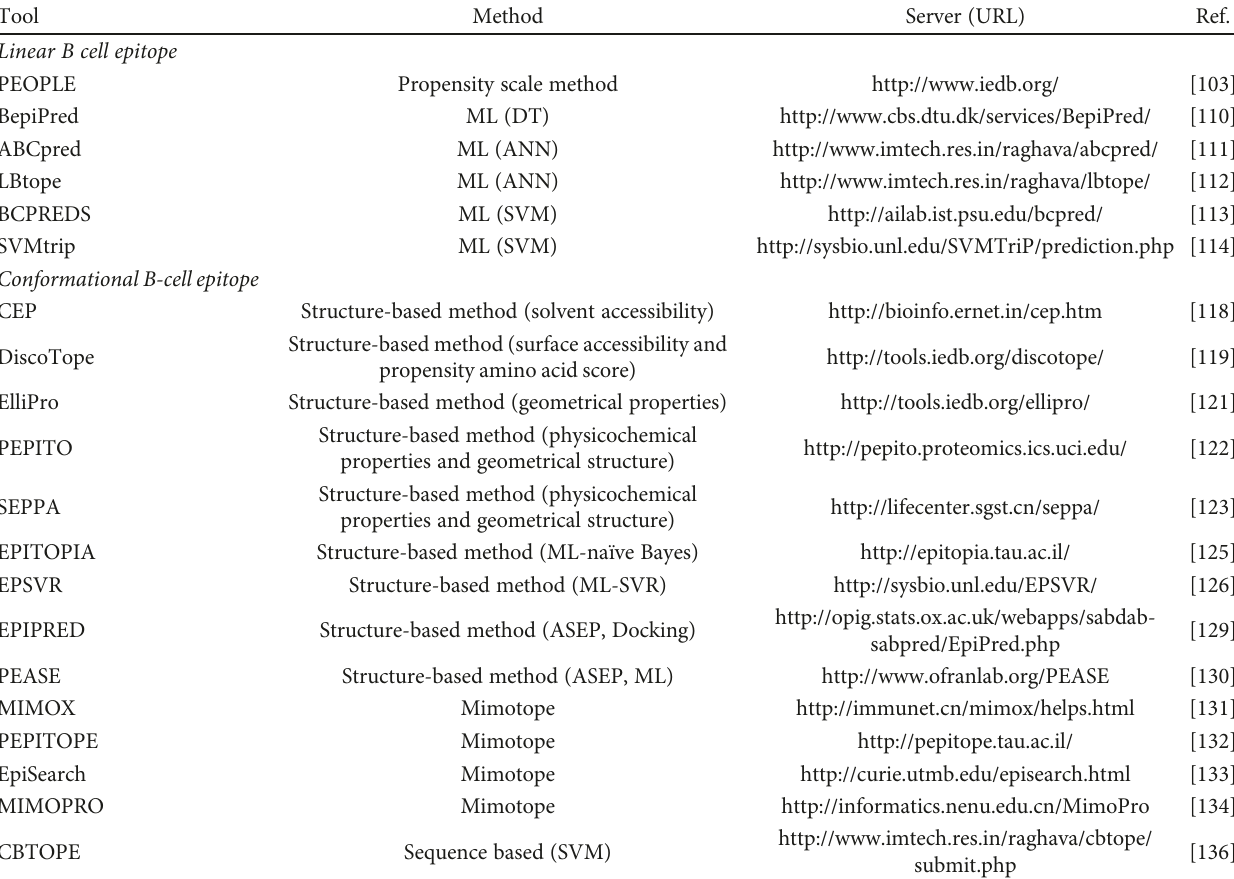
Table 2: Selected B-cell epitope prediction methods available for free online